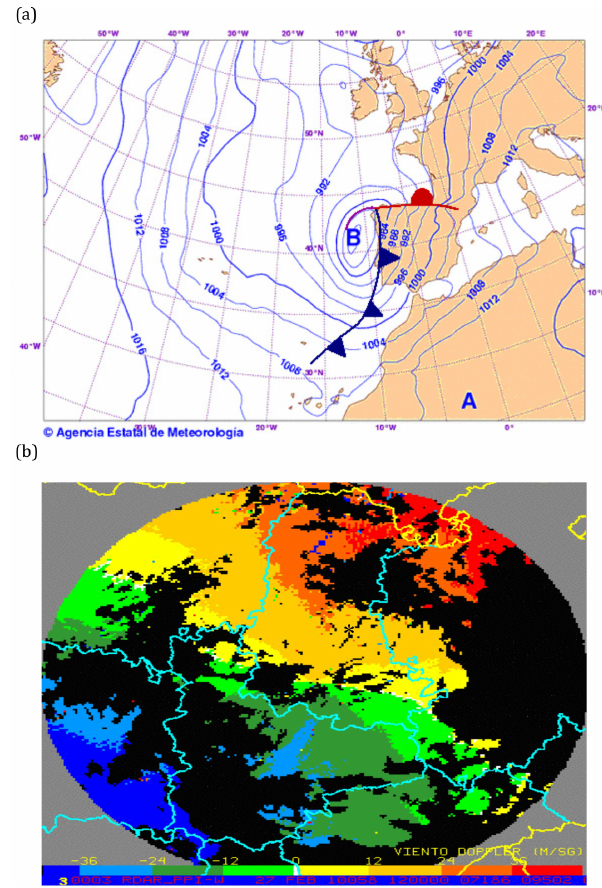
Figure 8. 27 February 2010: (a) Surface pressure pattern at 12:00UTC; and (b) Doppler radar wind (ms − 1 ) plan position in- dicator (PPI) image over the Spanish region of Castilla–León. Neg- ative values indicate approaching movement towards the radar posi- tion (*). Positive values indicate that points are moving away from the radar